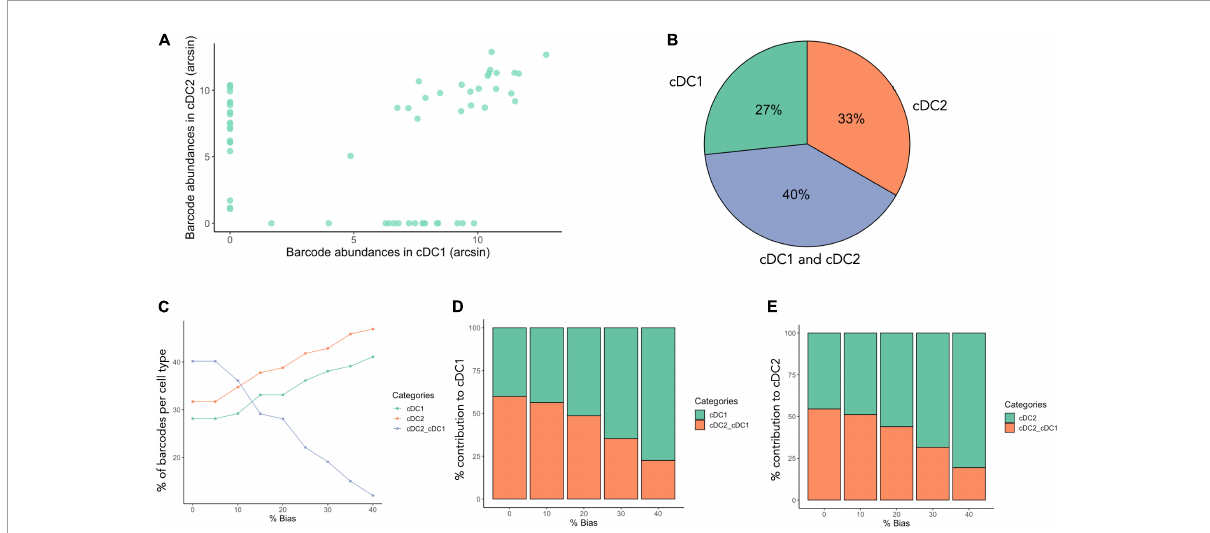
FIGURE6 Barcode sharing and lineage bias across lung-resident cDC subsets. (A) The dotplot shows the arcsin transformed barcode abundance across cDC1 and cDC2. On this visualization each dot is a distinct barcode. Shared bi-outcome barcodes are on the diagonal and uni-outcome barcodes are on the respective X and Y axes. (B) Proportion of total unique barcodes that are shared between cDC1 and cDC2. Bi-outcome barcodes are shown in blue while the red and green segments represent unipotent barcodes for cDC1 and cDC2, respectively. This plot represents data pooled across all three mice. (C–E) Lineage bias classifier using different thresholds (indicated on top of the graph, 0–40%) using data pooled from all three mice. N = 3 mice, total of 60 barcodes (m1 = 32 barcodes, m2 = 17 barcodes, m3 = 11